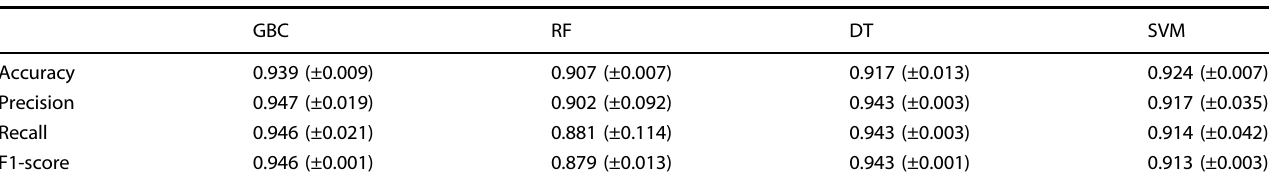
Table 1. Performance metrics obtained by tenfold CV for perovskites classi fi